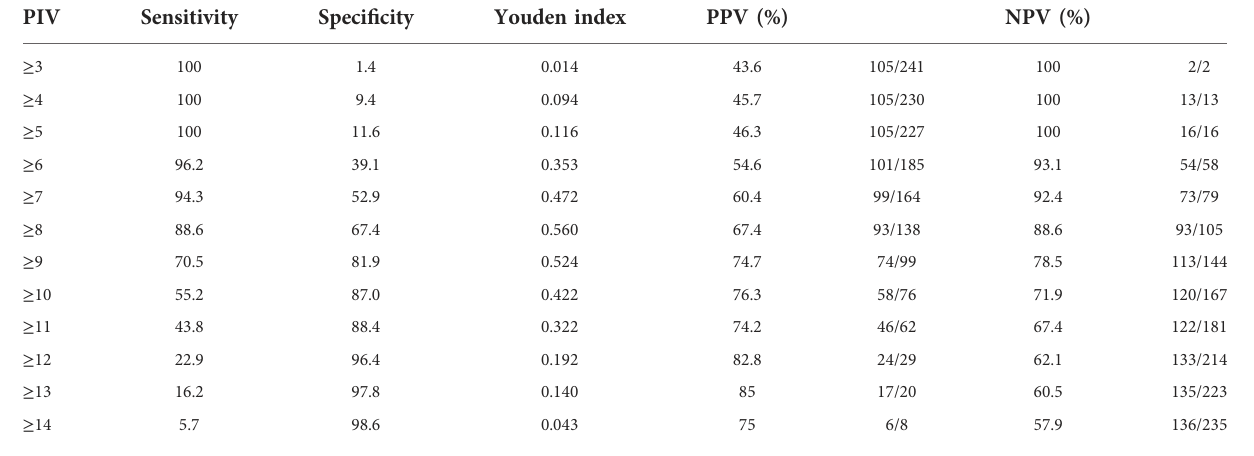
TABLE 5 Predictive index